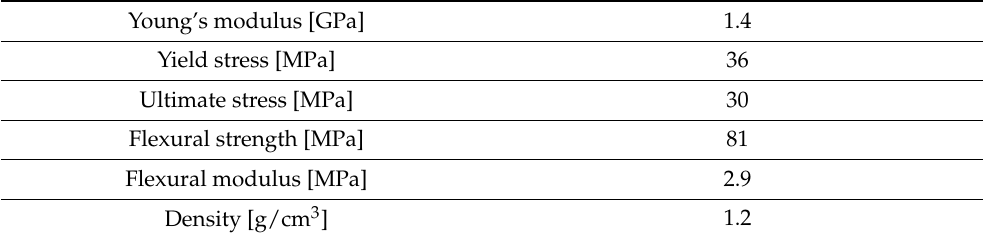
Table 2. Mechanical properties of Onyx.